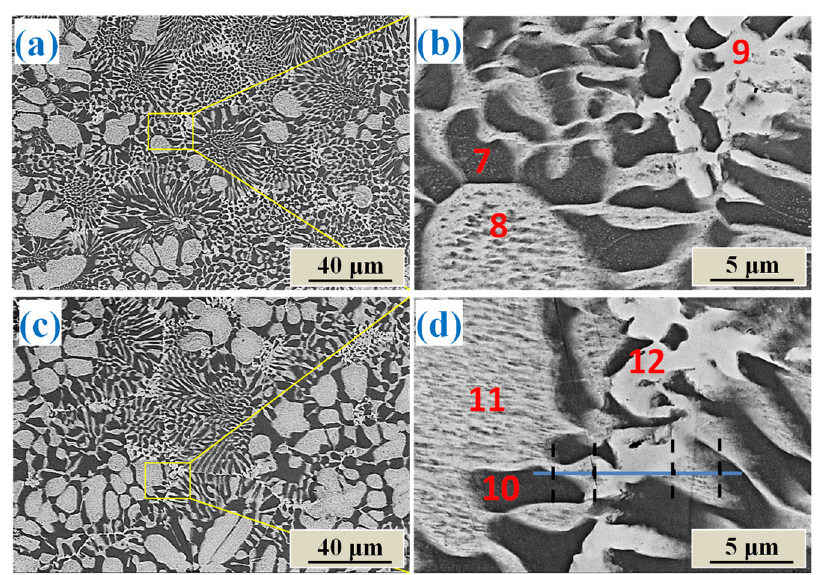
Figure 3. SEM backscattering electron micrographs of ( a , b ) AlCrFeNiTi 0.5 Mo 0.3 , ( c , d ) AlCrFeN- iTi 0.5 Mo 0.4 HEAs. ( b , d ) Magnified images of the regions marked by yellow squares in images ( a , c ). ( e ) Line scans analysis of the interface between brightest precipitate and adjacent BCC phase in AlCrFeNiTi 0.5 Mo 0.4 HEA shown in ( d ).